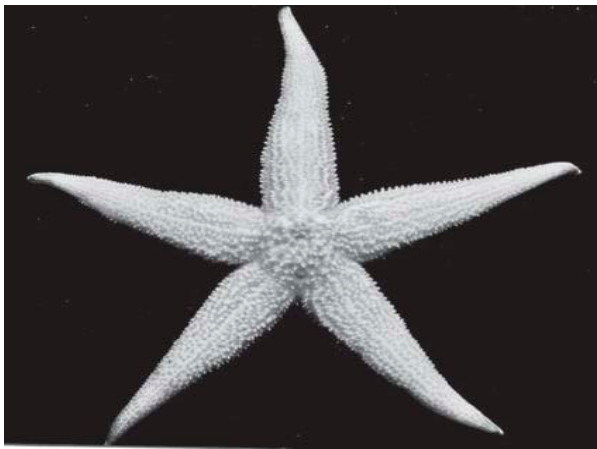
Figure 1. Starfish shape [41].